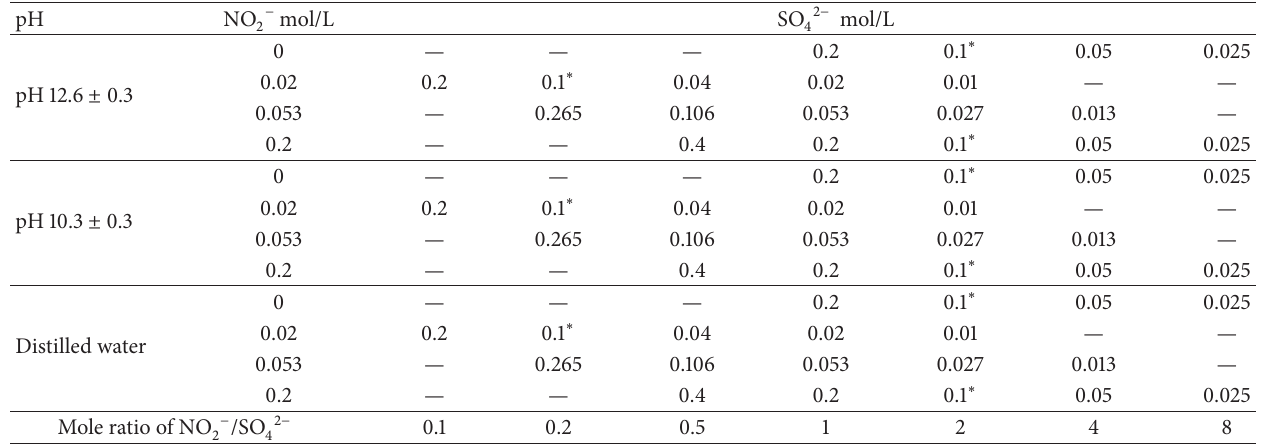
Table 2: Experimental design for sulfate-induced